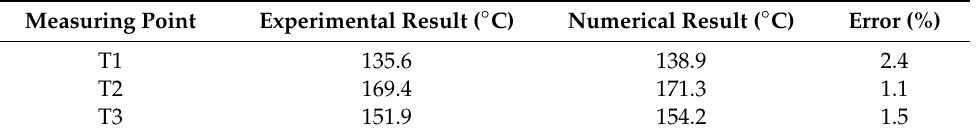
Table 6. Temperature difference between experimental and numerical analysis.